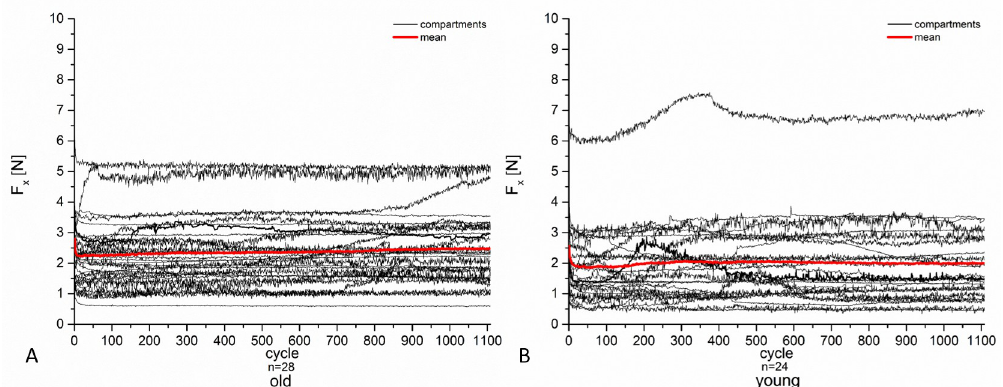
Fig 9. The figure represents the graphs of the friction forces of the cartilage of the old animals (A) and the young animals (B) over the entire running time. The red lines represent the mean curves of the compartments included in the tribological exposure in the respective